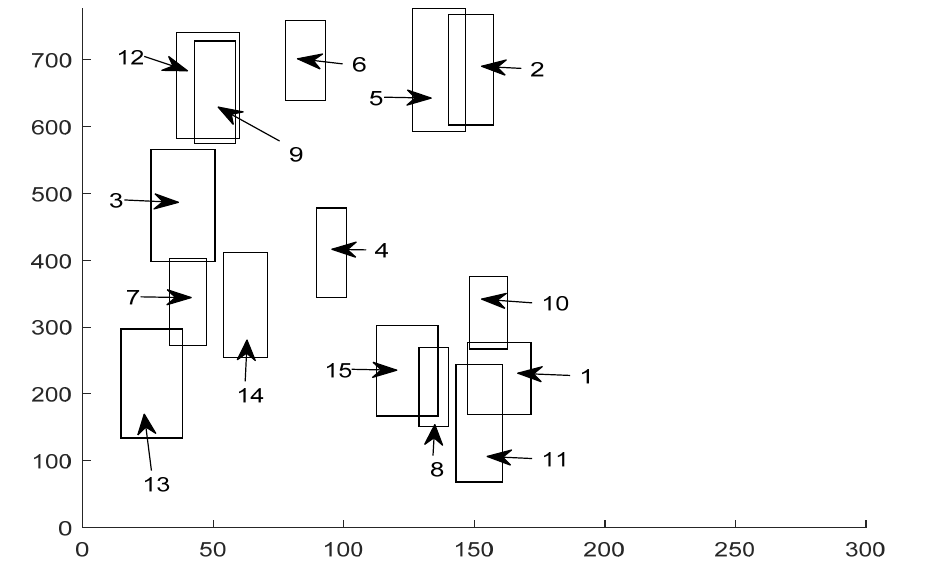
Figure 13. The berthing plan based on the original ship data. Table 3. Summary data of di ff erent